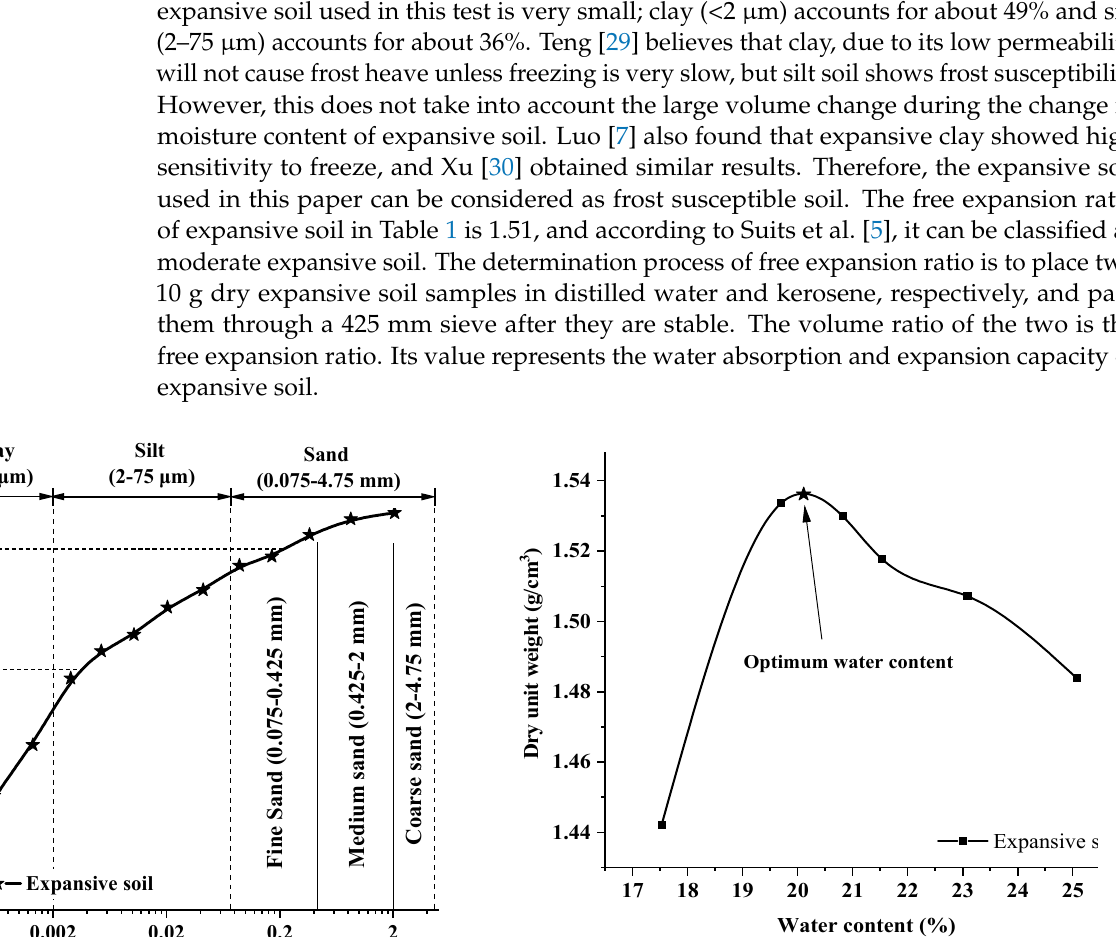
Figure 2. Slope preparation process. (( a ) layered compaction; ( b ) surface scraping; ( c ) dismantling mold; ( d ) slope cutting).